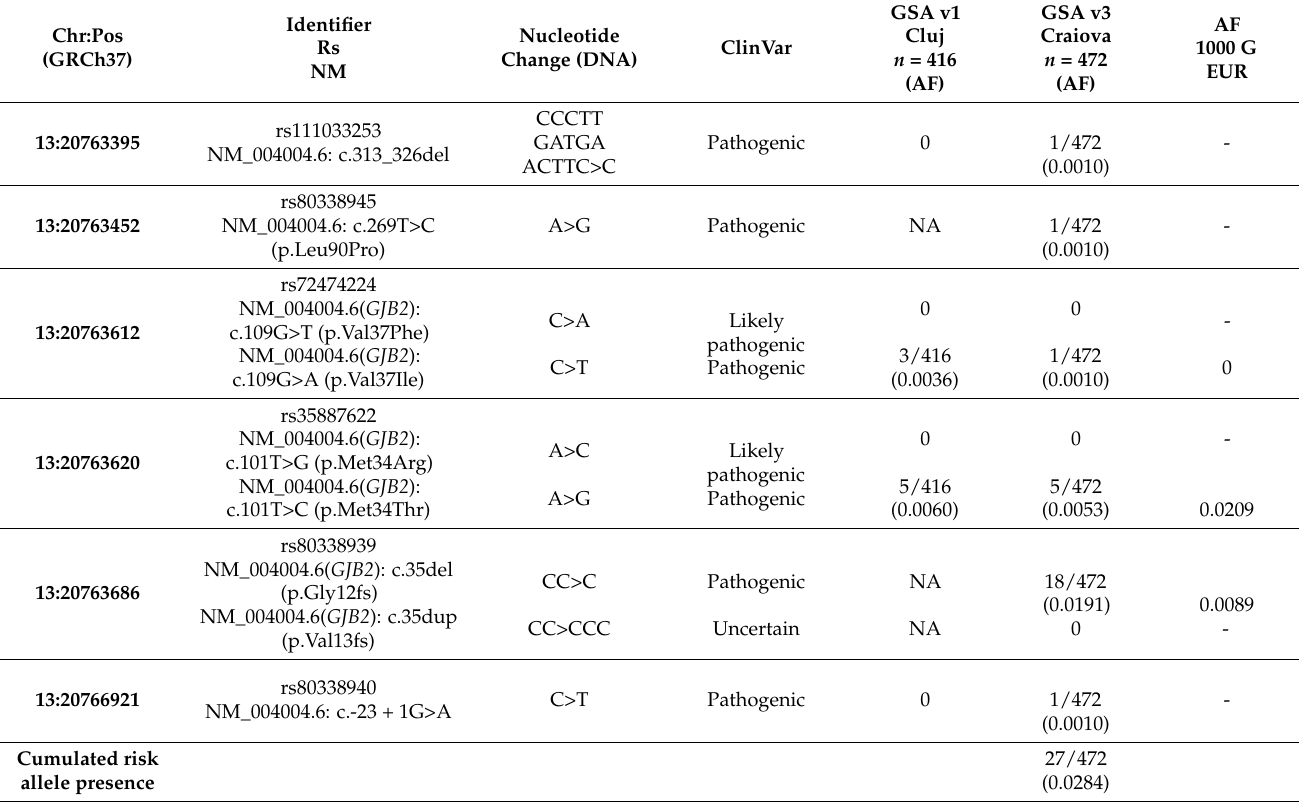
Table 3. Carrier status of variants qualified as likely pathogenic or pathogenic present on the GSA v1 or GSA v3 chips, with at least one allele identified in the Romanian cohorts